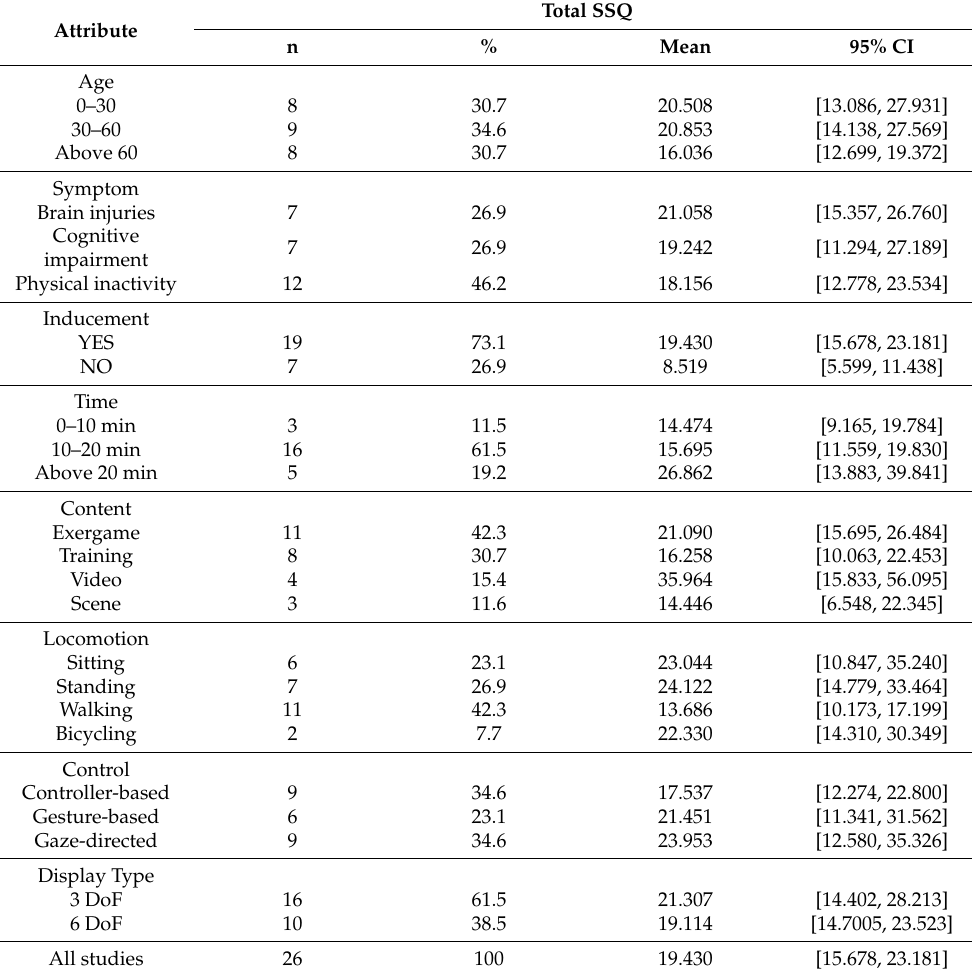
Table 5. SSQ total